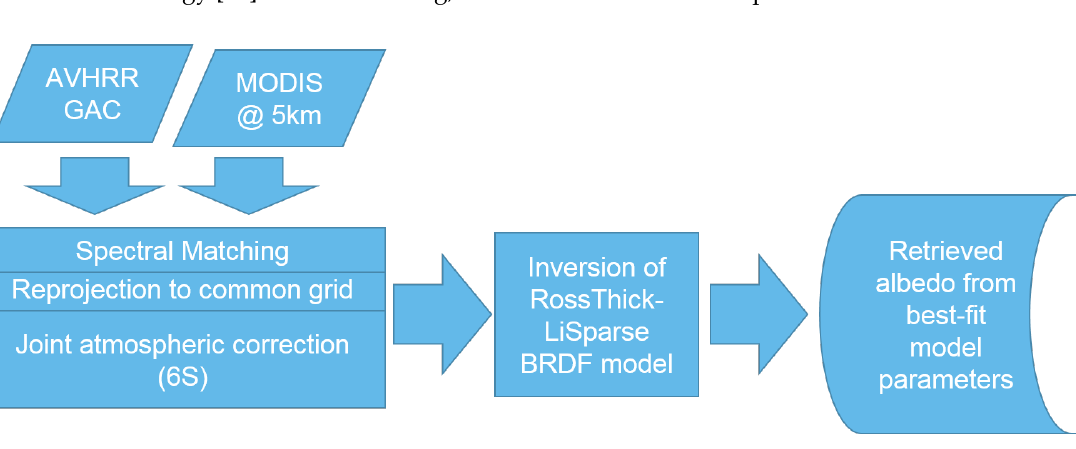
Figure 1. The joint MODIS-AVHRR land surface albedo retrieval processing flow.